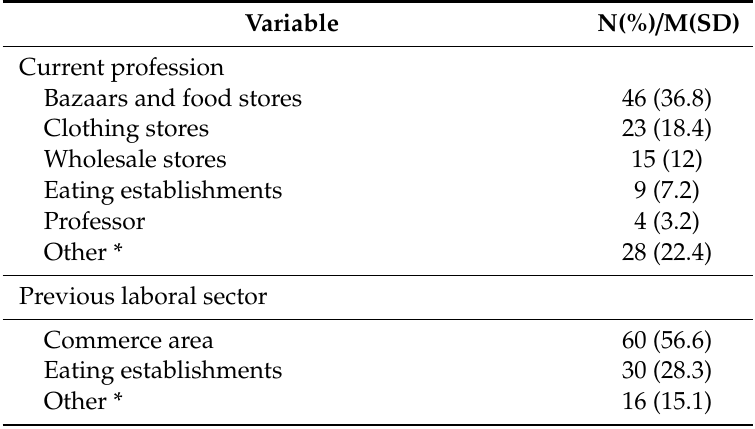
Table 2. Working conditions and health problems in Chinese